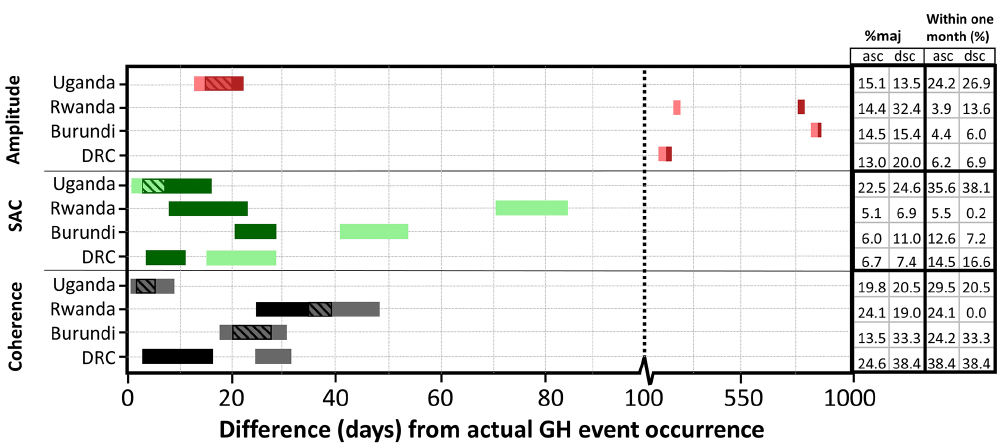
Figure 8. Estimated timing from the individual GH feature scale (workflow 2) for amplitude, detrended amplitude (red), SAC (green), coherence, and detrended coherence (black). The darker coloured bar represents the ascending track results. The length of bars represent the uncertainty in timing (see Sect. 3.3). Dashed lines on the bars represent the overlap between the ascending and descending track results. In the % maj column we present the percentage of individual GH features over the total number of individual GH features that were included in the majority vote separated for the ascending (asc) and descending (dsc) track. In the “within one month” column we present the percentage of individual GH features over the total number of individual GH features that estimated a date within one month of the actual event